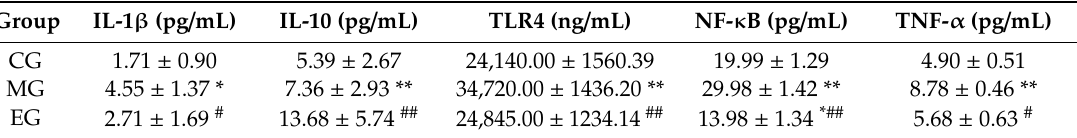
Table 4. Changes of expressions of IL-1 β and IL-10 in the hippocampus of mice. Group